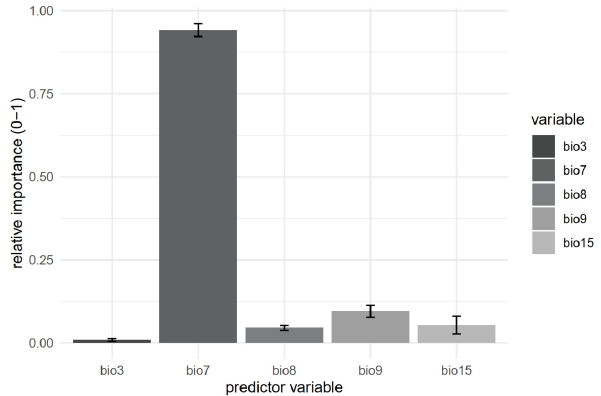
Figure 2. Relative contributions of five selected predictor variables to the species distribution based on ensemble modeling strategies for Buxbaumia viridis. The bars indicate the mean value of built ensemble models with standard errors (Bio3 – Isothermality; Bio7 – Temperature Annual Range; Bio8 – Mean Temperature of Wettest Quarter; Bio9 – Mean Temperature of Driest Quarter and Bio15 – Precipitation Seasonality). The currently suitable area for the species covers an area of approximately 1947 km 2 . Future predictions of suitable habitats for the species are shown in Figure 3. It can be seen that all future climate scenarios predict a significantly large reduction in B. viridis national distribution range, that is the average of ≈ 102.3 km 2 of suitable surface area across the climatic models by the year 2050, and only ≈ 19 km 2 by the year 2070, for SSP 2-4.5 scenario. Regarding the SSP 5.8-5 average of the predicted range across climatic models is ≈ 22.6 km 2 for the year 2050 and none of the suitable territory for the species by the year 2070. It is important to emphasize that there was no difference in the percentage of habitat loss under both assumptions of unlimited and any dispersal. Predictions under SSP 2.4-5 (intermediate GHG emissions) did not show a total loss of suitable habitat in any of the performed climate models (Figure 4 A). The percentage of lost habitat for this emission scenario varies between ≈ 92.8 and 97% for the year 2050 and between ≈ 98.3 and 99.9% across different climatic models. On the other hand, predictions under SSP 5.8-5 emissions (e.g., very high GHG emis- sions) showed total loss of suitable habitat until the year 2070 for all climatic models (Fig- ure 4B). Total loss of suitable habitat is also predicted for one climatic model (CNRM- CM6-1) until the year 2050, while reduction of suitable habitat varies between ≈ 98.1 and 98.4% for the other two models (Earth3-Veg and MIROC6, respectively).